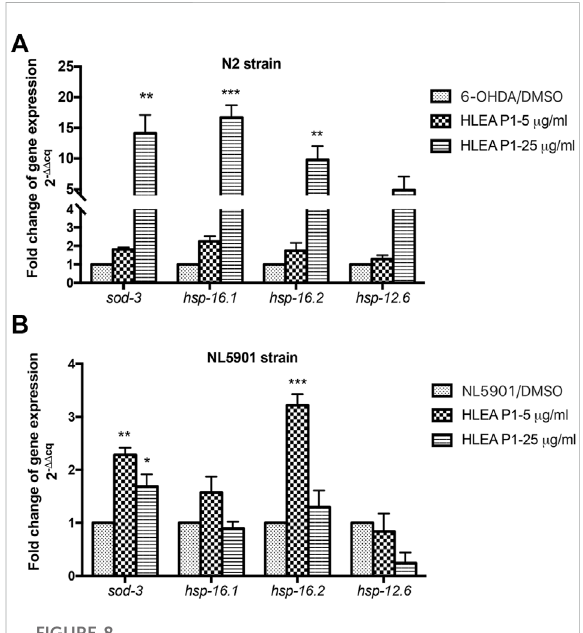
FIGURE 8 Effect of HLEA-P1 on expressions of mRNAs of DAF-16 target genes in C. elegans PD models. Graphical representation for fold changeofgeneexpressionlevel(2 − ( ΔΔ Cq) )ofDAF-16targetgenesin 6-OHDA-induced worms (A) and NL5901 worms overexpressing α -synuclein (B) . The relative mRNA expressions were normalized with internal control act-1 . The data represented as a mean ± SEM (three independent replicates, n = 800 – 1,000 number of animals per replicate). The asterisk (*) indicates signi fi cant differences between untreated group (DMSO) and HLEA-P1-treated group, * p < .05, ** p < .01, *** p <